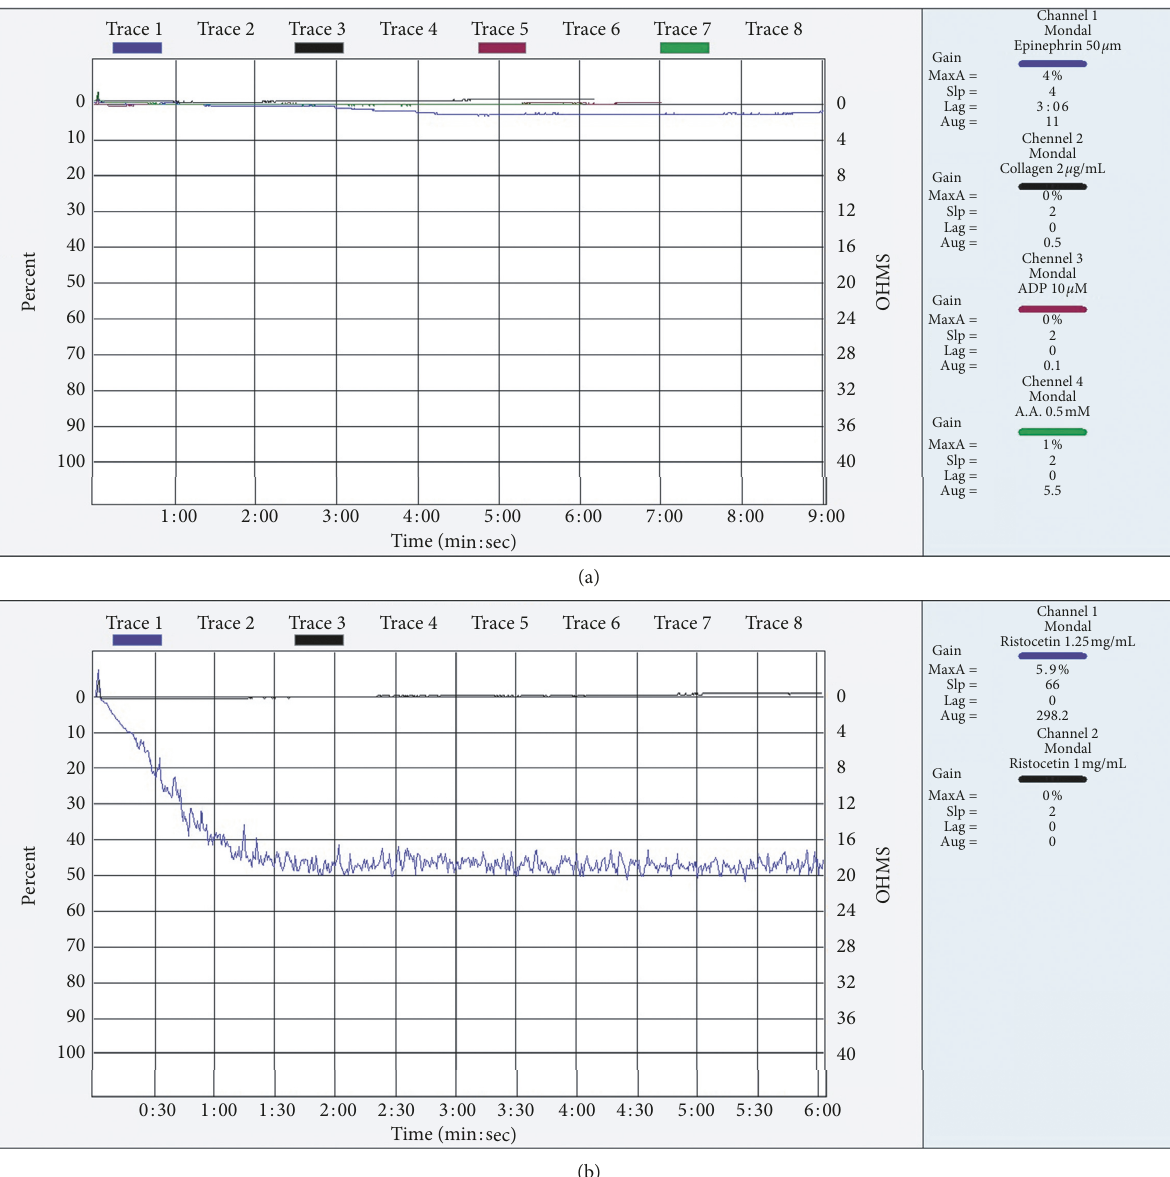
Figure 1: Platelet aggregation test by LTA at the time diagnosis. (a) Platelet aggregation test with collagen, ADP, thrombin, and arachidonic acid shows a complete absence of platelet aggregation. (b) Platelet aggregation test with ristocetin shows a normal